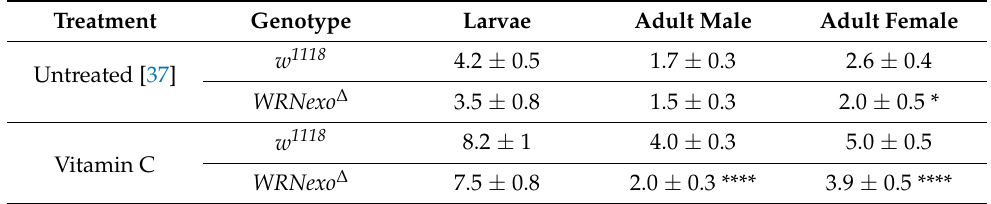
Table 1. Vitamin C-treated larval and adult dry mass/10 individuals